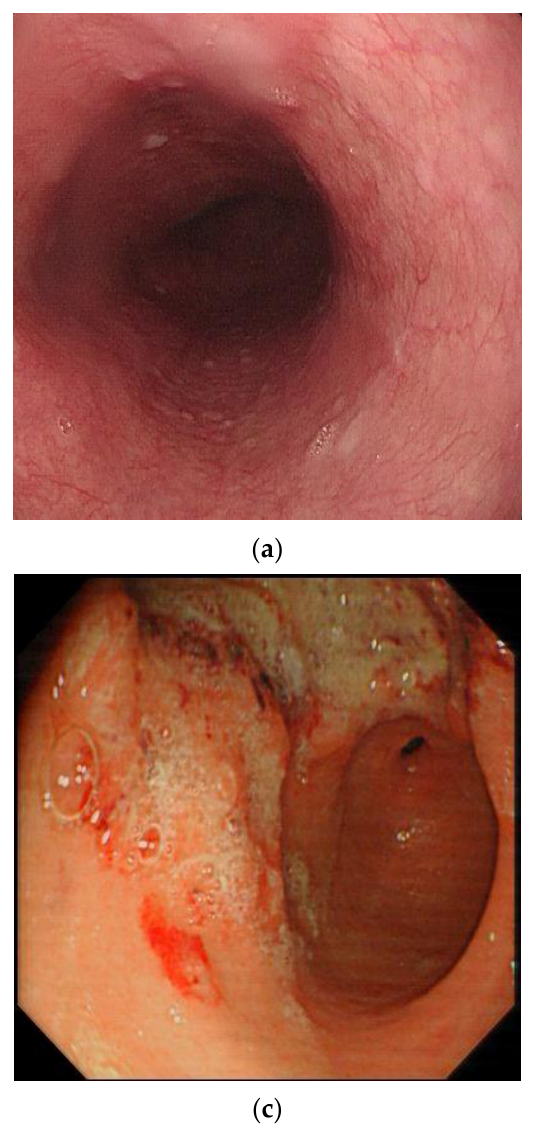
Figure 2. Examples of endoscopic images of normal esophagus, early esophageal cancer (EC), gastric cancer, and duodenal ulcer: ( a ) normal esophagus, ( b ) early EC, ( c ) gastric cancer, and ( d ) duodenal ulcer.